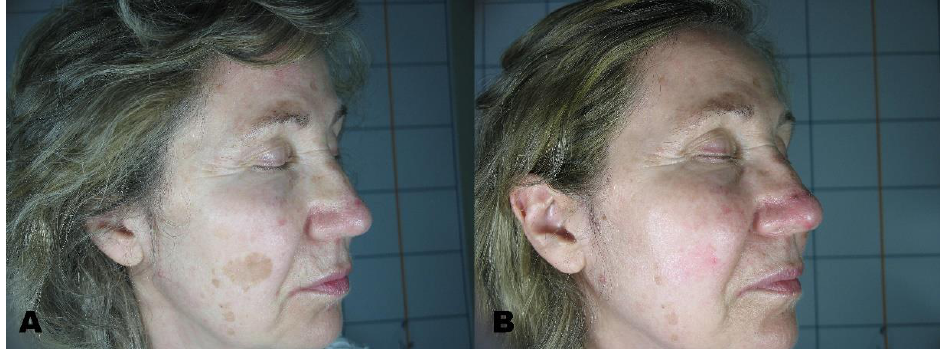
Figure 2. ( A ) Solar Lentigo before treatment; ( B ) region three months after the last session.